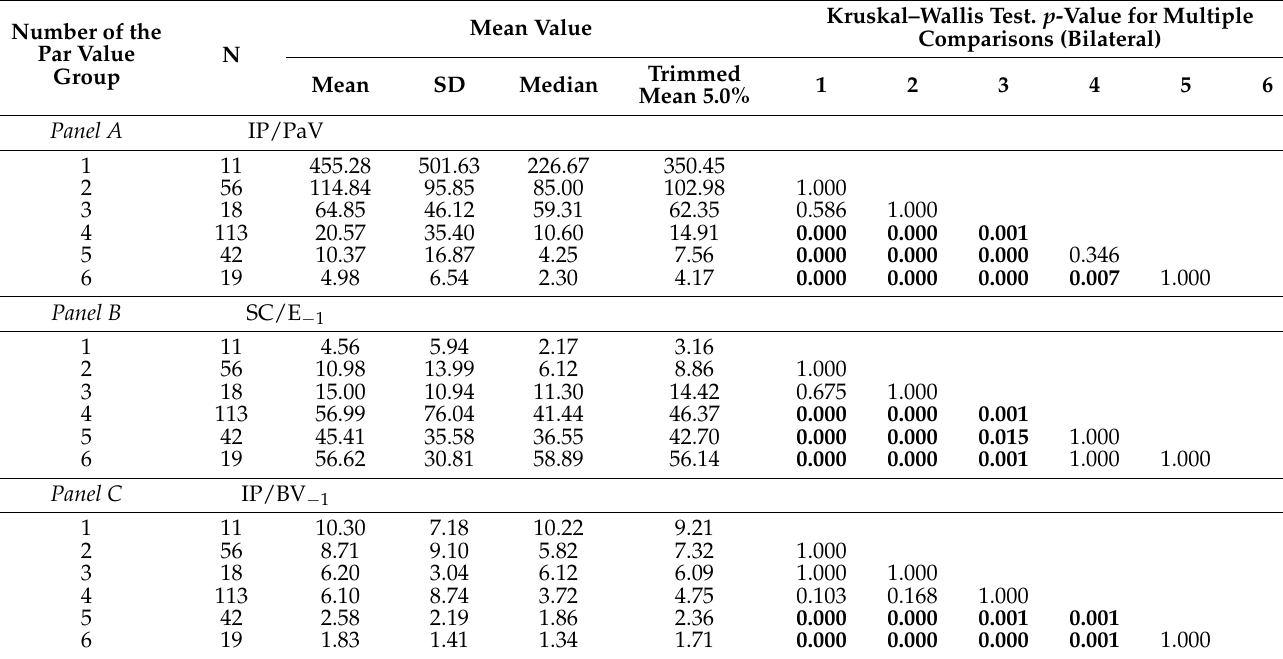
Table 8. Second-degree financing parameters depending on